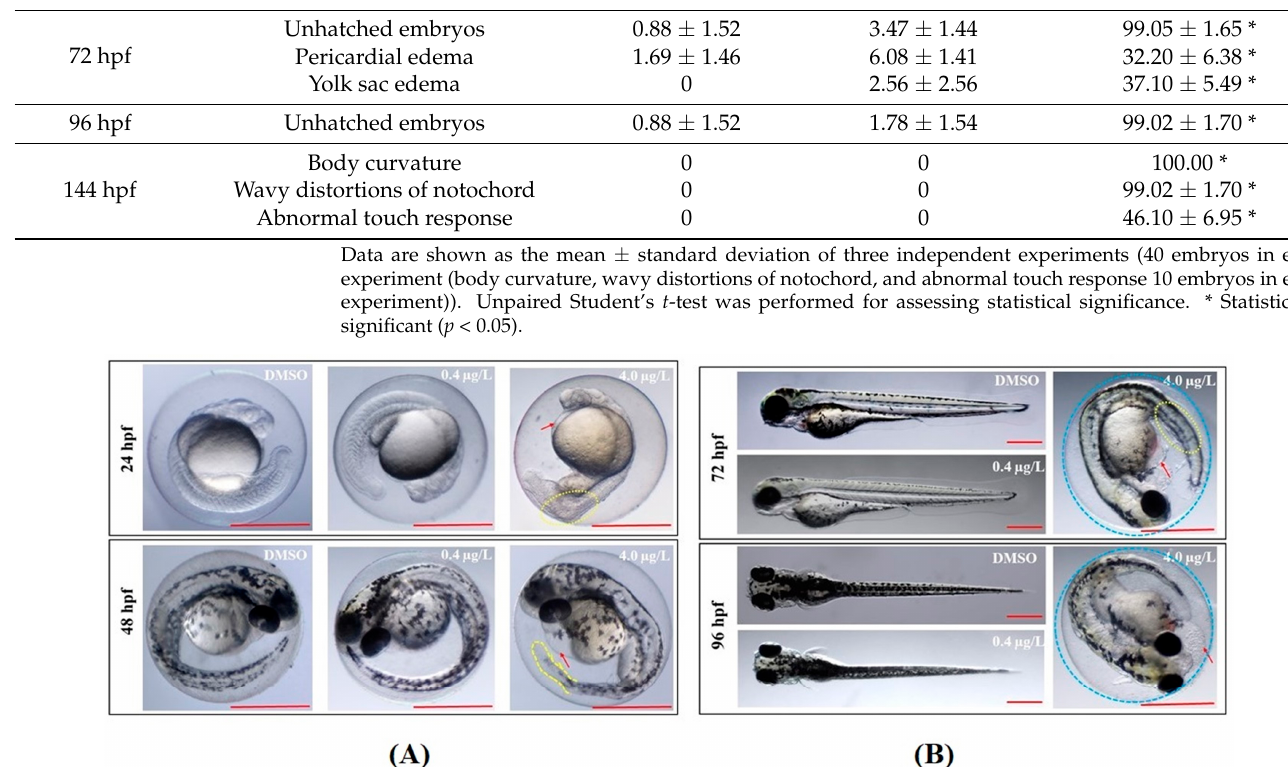
Data are shown as the mean ± standard deviation of three independent experiments (40 embryos in each experiment (body curvature, wavy distortions of notochord, and abnormal touch response 10 embryos in each experiment)). Unpaired Student’s t -test was performed for assessing statistical sig- nificance. * Statistically significant ( p < 0.05). ZF exhibit average heartbeats of 150–200 beats per min (bpm) between 30 and 60 hpf at 28 °C [25]. Thiram affected ZF cardiac function at a dose of 4.0 μ g/L. DMZF had mean heart rates of 170.4 ± 7.1 (48 hpf), 185.2 ± 9.8 (72 hpf), and 194.2 ± 11.3 (96 hpf) bpm (Figure 2). LTZF exhibited similar mean heart rates of 172.6 ± 11.8 (48 hpf), 182.8 ± 10.2 (72 hpf), and 193.6 ± 12.4 (96 hpf) bpm. However, HTZF showed significantly lower heart rates than did DTZF (Video S1), at 145.0 ± 16.1 (48 hpf), 157.2 ± 8.4 (72 hpf), and 166.2 ± 11.5 (96 hpf) bpm. There was a high incidence of PE in the HTZF group (Table 1). At 24 hpf, 12.8% of ZF had edema symptoms, with PE increasing to 32.2% at 72 hpf. Hyperemia (Figure 1) and blood flow abnormalities (data not shown) were also evident in the HTZF group.